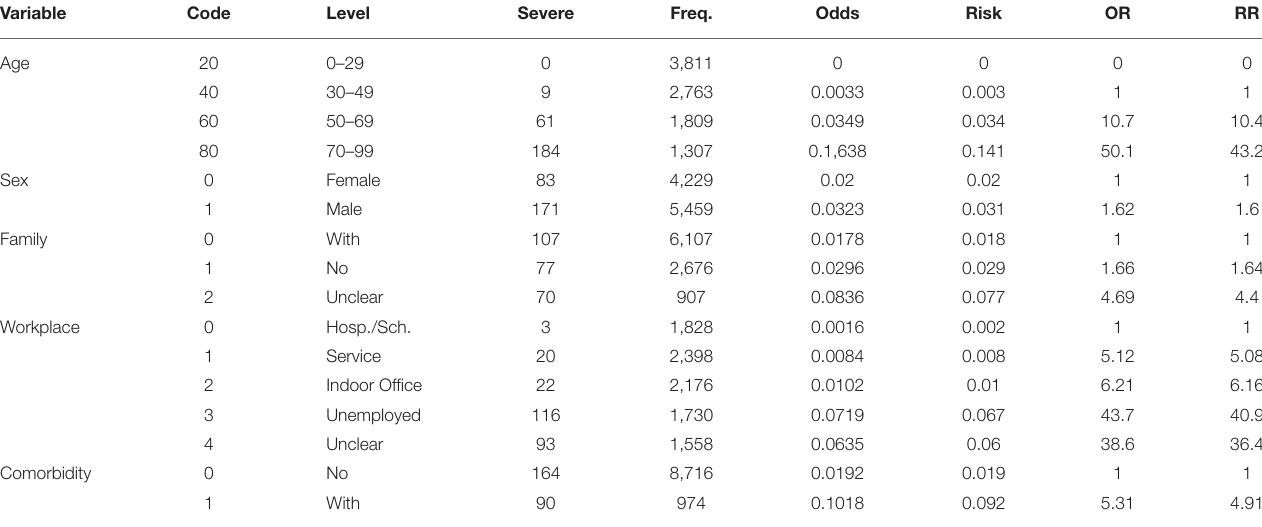
TABLE 5 | Frequency of severe cases and odds ratio (OR) and relative risk